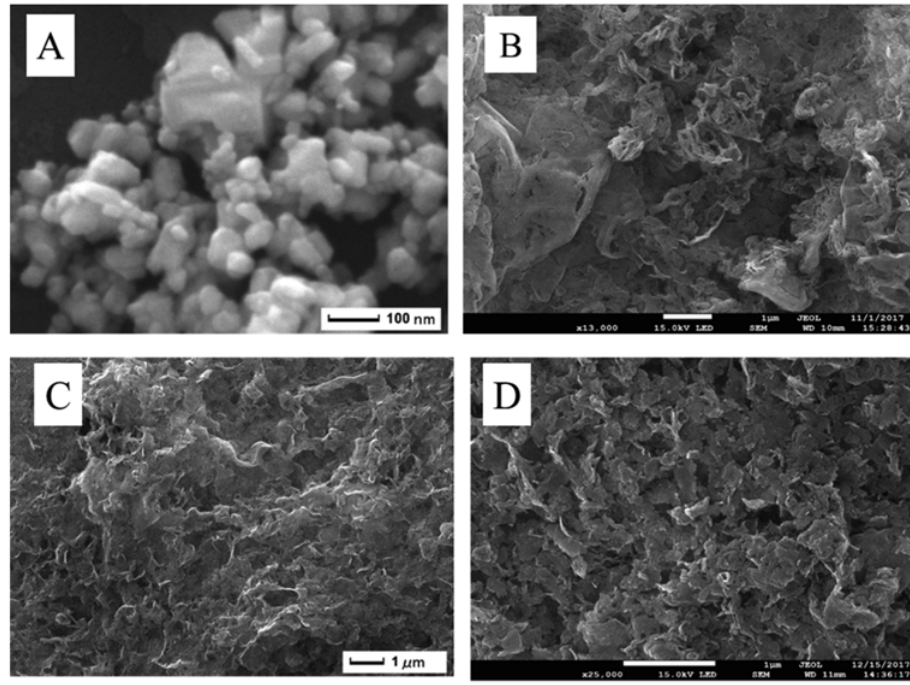
Figure 12. SEM images of ( A ) WO 3 , ( B ) bulk g ‐ C 3 N 4 , ( C ) few ‐ layer g ‐ C 3 N 4 , ( D ) WO 3 /few ‐ layer g ‐ C 3 N 4 . Reproduced with permission [131]. Copyright 2019, Elsevier.